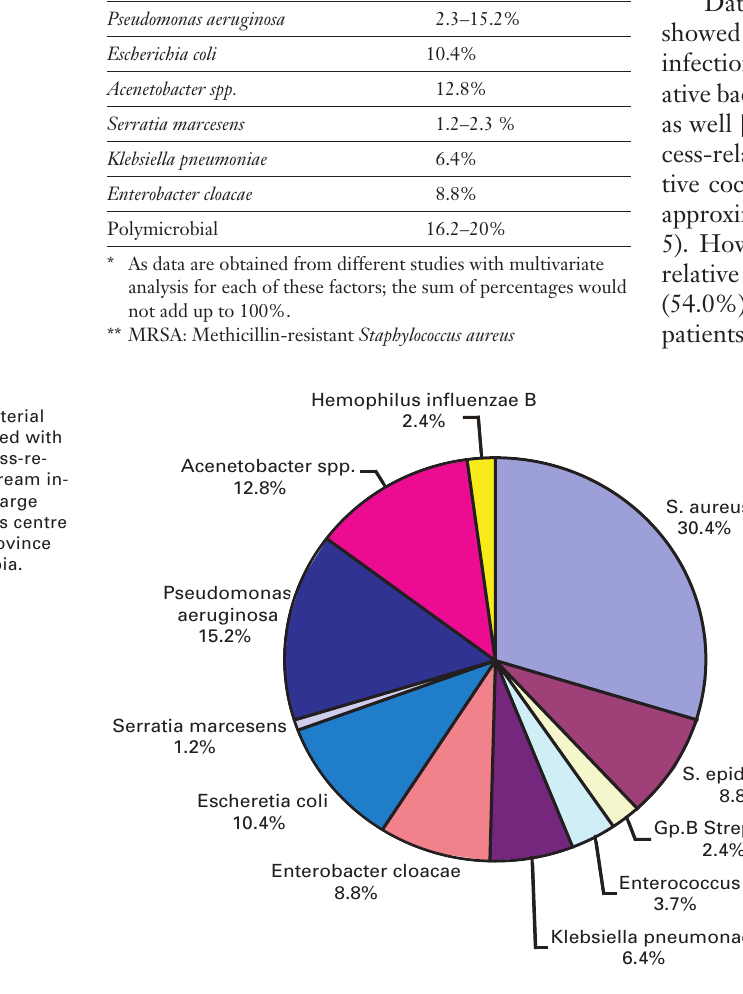
Bacterial flora fre- quently associated with HD catheter-re- lated blood stream infections* [5, 7, 8, 15, 28, 34–36,